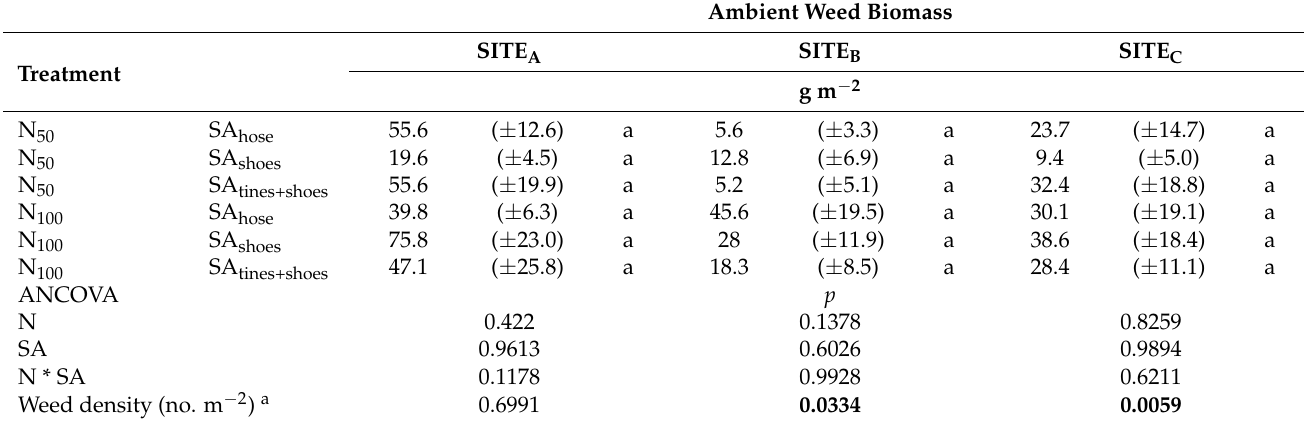
Table 6. The effect of nitrogen rate (N 100 and N 50 ) and slurry application method (SA hose , SA shoes , and SA tines+shoes ) on intra-row ambient weed biomass (SITE A , SITE B and SITE C ). Data from each site were analyzed separately. A connecting letters report displays differences among treatments, whereby means not sharing a similar letter are significantly different ( p < 0.05). Significant main effects and interactions are highlighted in bold text ( p < 0.05). Standard errors are displayed in